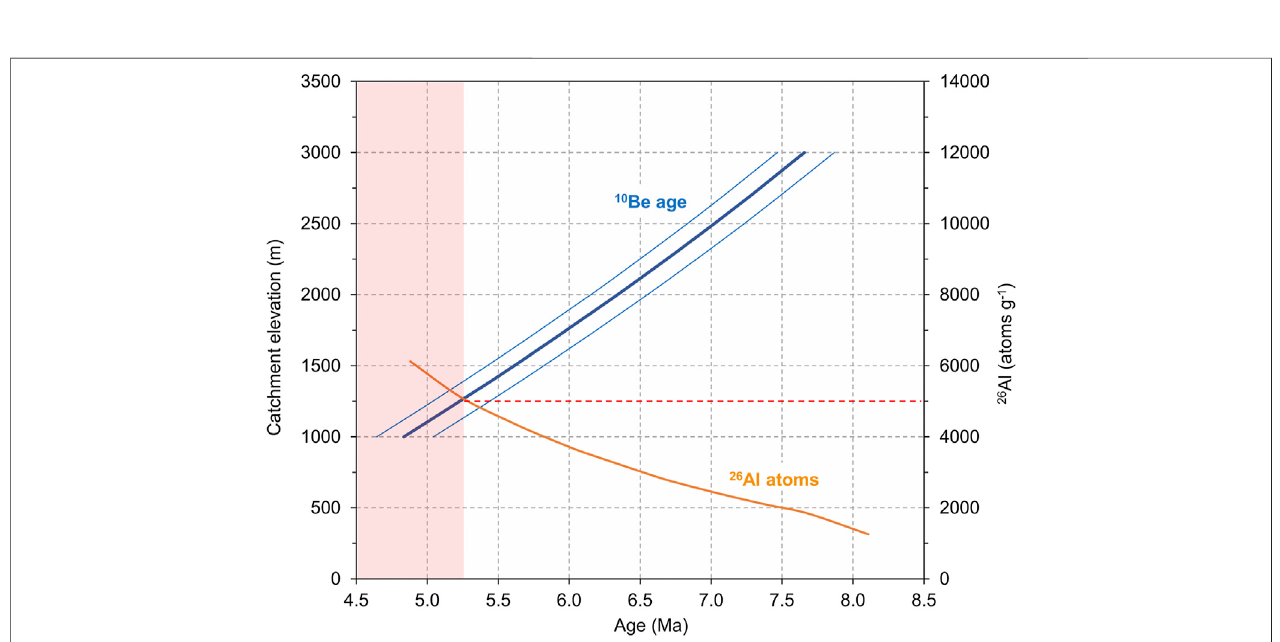
FIGURE10| Graphplottingthe 10 Beburialagesasafunctionofthecatchmentelevationbasedonasurfacesedimentexposuretimeof9,300 ± 930 yearscoupled with the calculated remaining 26 Al. The red dashed line at 5,000 26 Al atoms/g de fi nes the “ exclusion zone ” based on the absence of 26 Al in the sample. The line crosses the 10 Be age line at 5.25 Ma corresponding to a minimum catchment elevation of 1,250 m a.s.l.